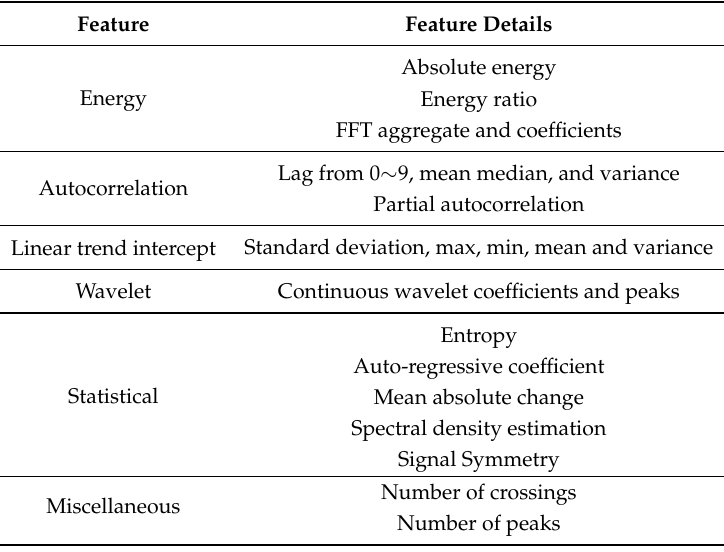
Table 2. A subset of the extracted